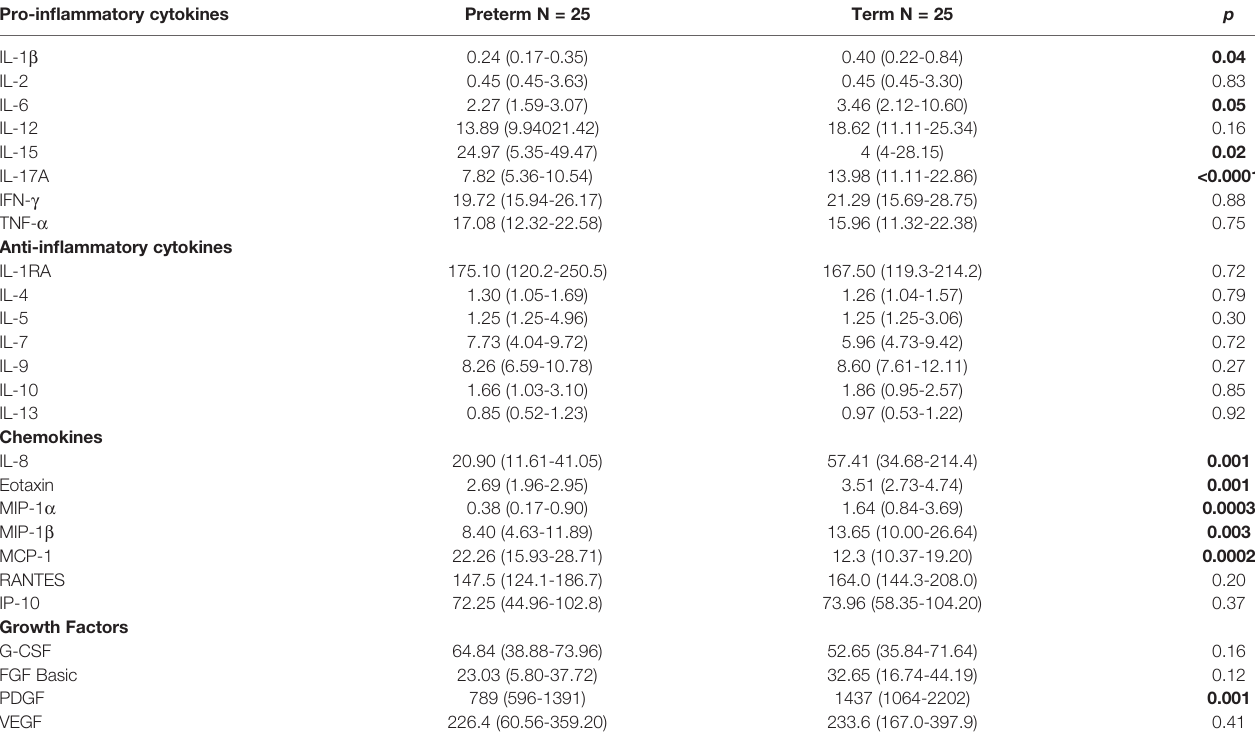
TABLE 2 | Plasma cytokine, chemokine, and growth factor levels in preterm and term infants*. Pro-in fl ammatory